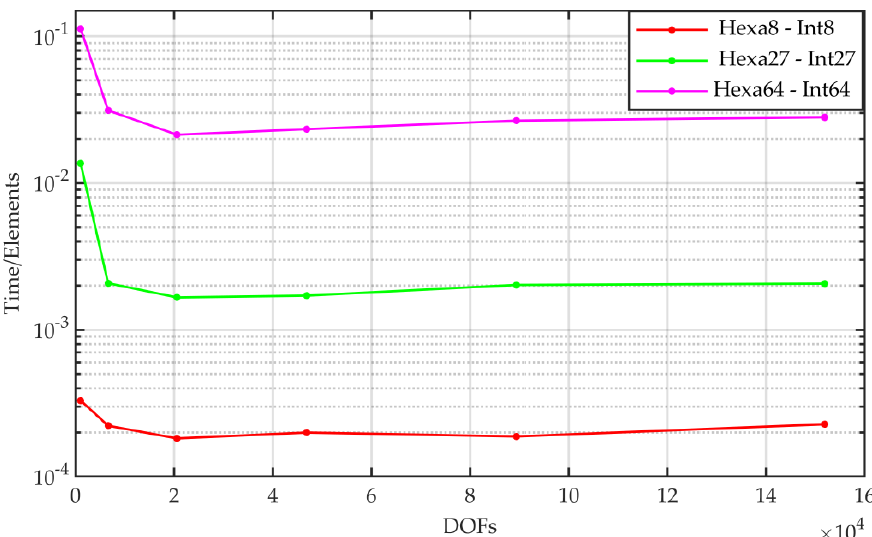
Figure 6. Average (per element) assembly time of the full − order linear, quadratic, and cubic FE formulations as a function of the number of DOFs.